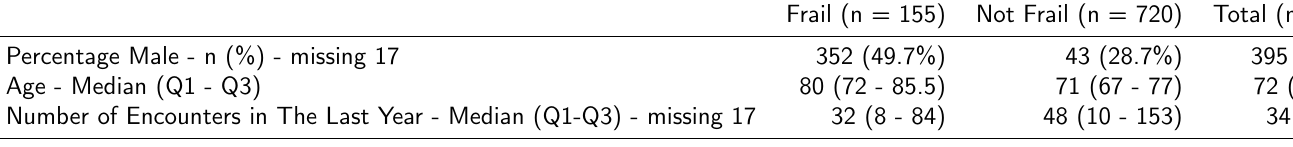
Table 1: Patient Characteristics